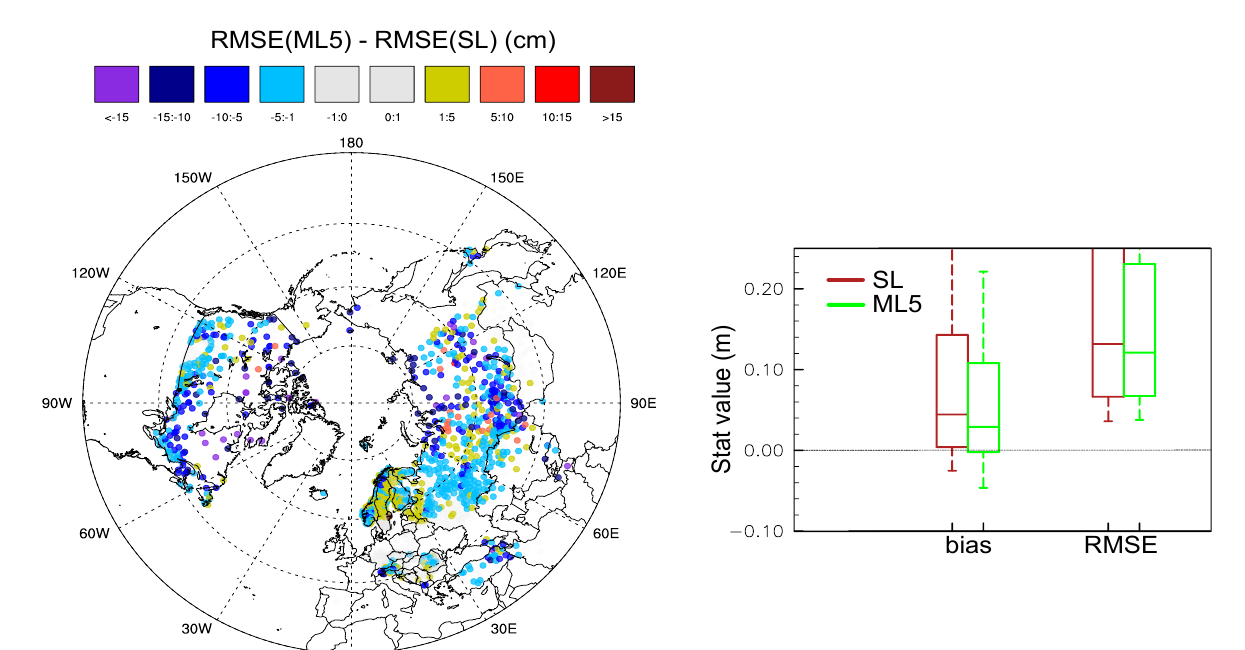
Figure 17. ( Left ) RMSE difference of snow depth between global offline simulation using the multi-layer (ML5) and single-layer (SL) snow schemes for December to May period from 2014 to 2018. Blue colours indicate reduced RMSE in ML5. ( Right ) boxplot of snow depth statistics (bias and RMSE) using stations considered in left panel.